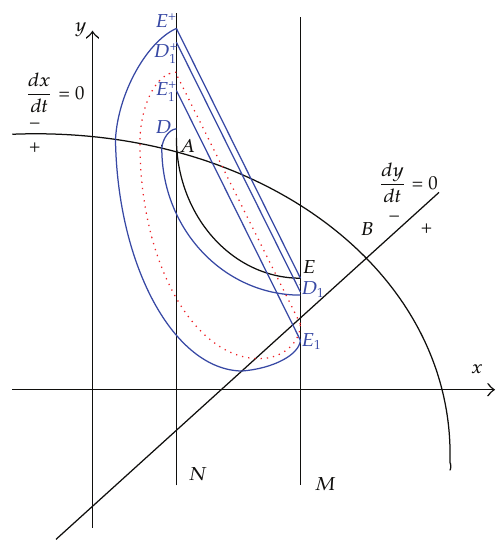
Figure 2: Illustration of system (cid:6) 1.3 (cid:7) for the case h < x ∗ , y